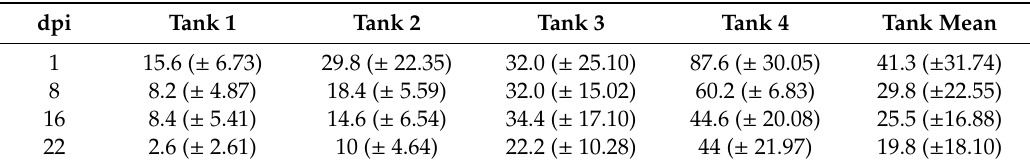
Table 2. Mean Caligus rogercresseyi abundance per tank on sampled Atlantic salmon ( Salmo salar ) throughout the experiment.